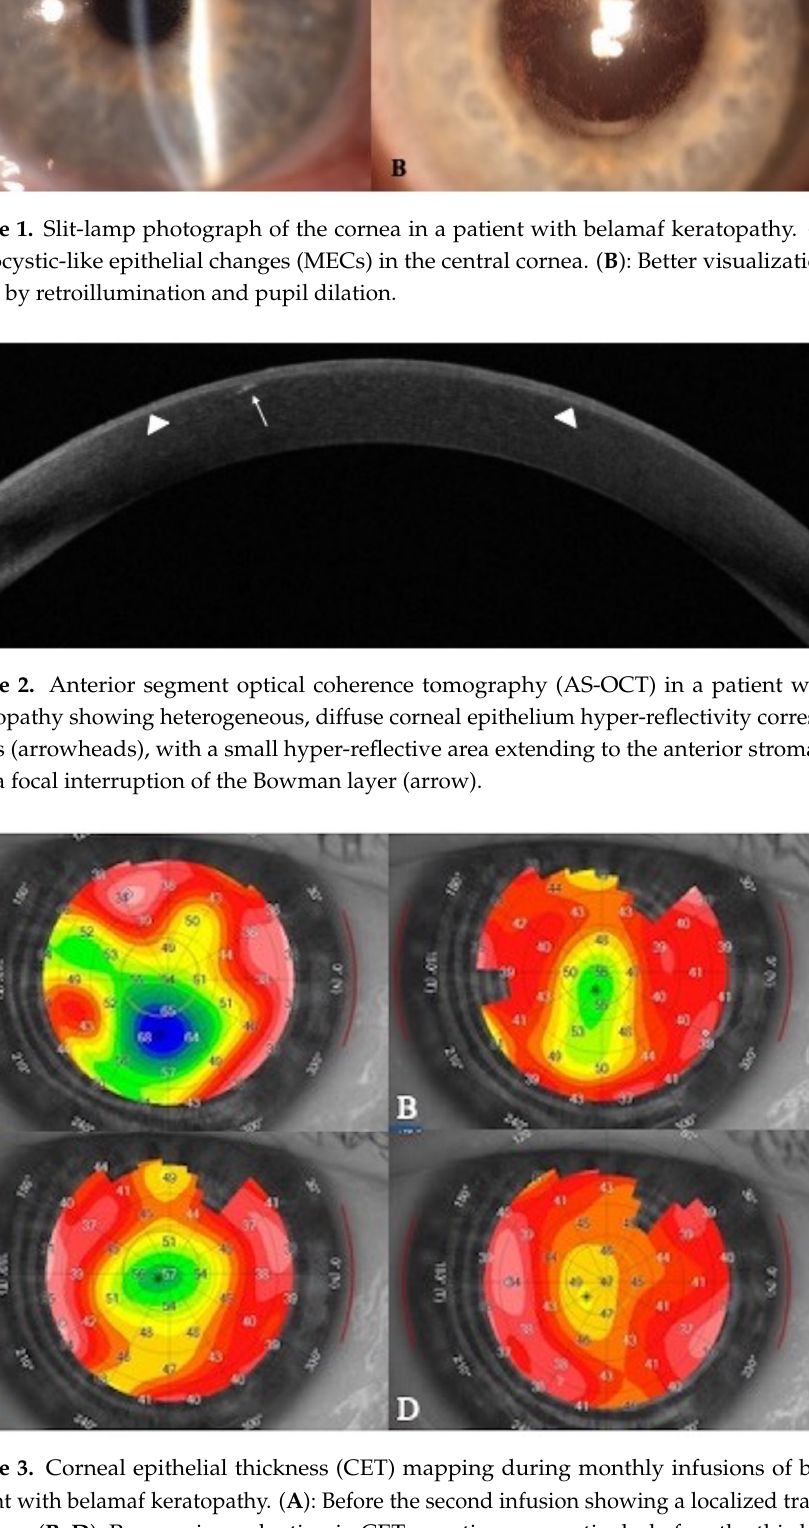
Figure 4. Graph showing the changes of average values of corneal epithelial thickness (CET) meas- ured in 5 sectors according to the infusion of belamaf in a representative patient. After the first dose, an increase in CET with the appearance of central MECs and vision reduction were found. The sec- ond dose was therefore delayed by one week. After the third and the fourth dose, a diffuse decrease in CET was assessed, followed by a “plateau phase” after the fifth dose. CET values are expressed in micron.